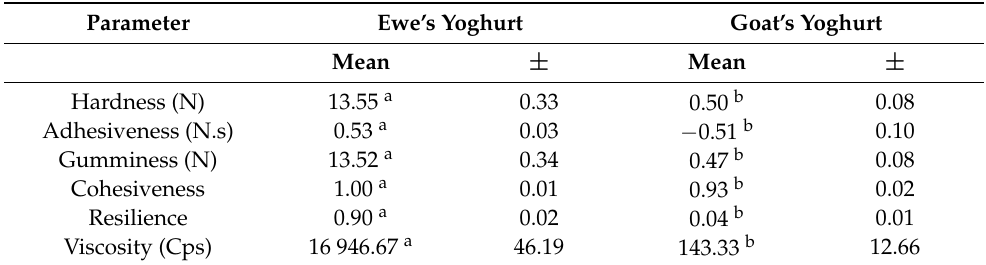
Table 2. Texture parameters of ewe’s and goat’s yoghurts one day after production (mean values and standard